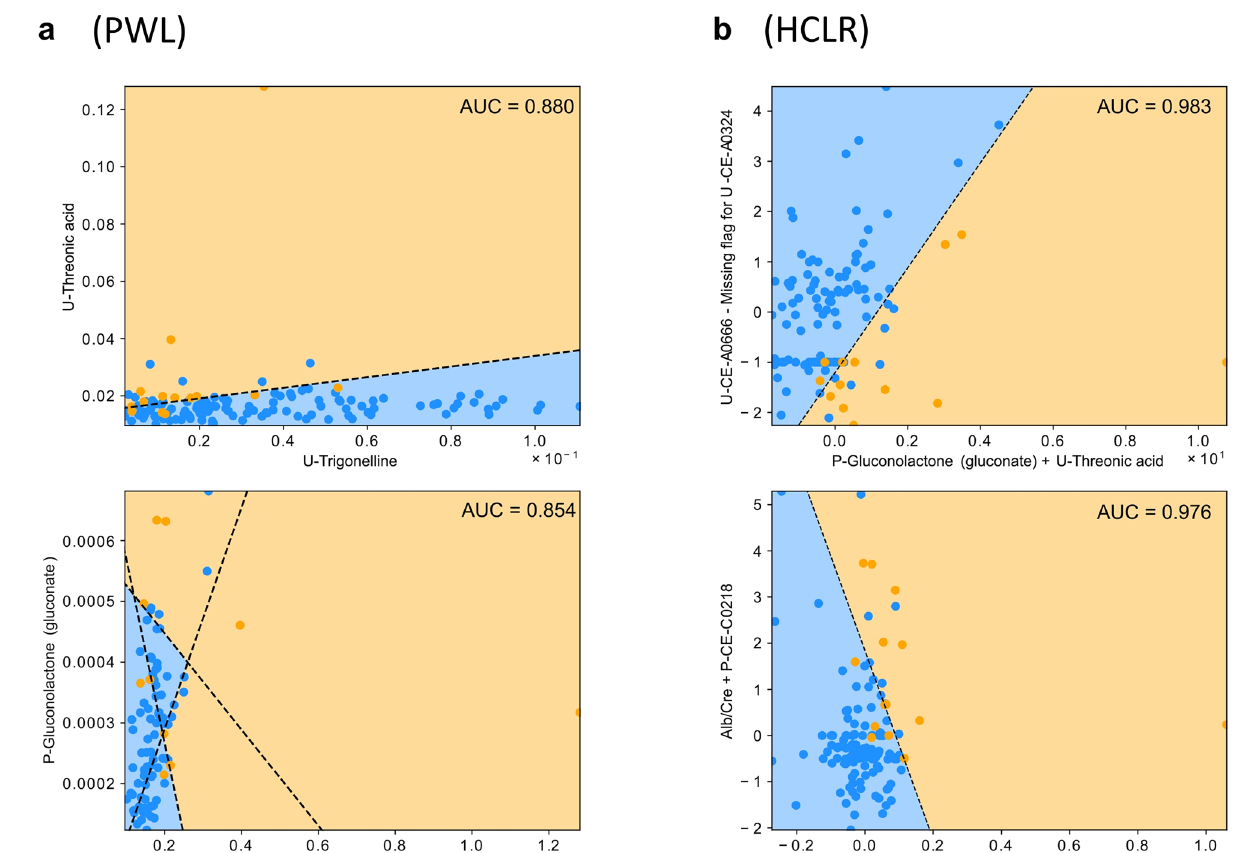
Figure 3. Representative plots of PWL model and HCLR model. Representative plots of ( a ) PWL and ( b ) HCLR models with high AUC values. The orange and blue areas show the regions classified as rapid decliners and others by each model, respectively. The orange and blue points correspond to the rapid decliners and others in the dataset, respectively. The dashed line represents the classification boundaries by setting the threshold level of the rapid decliner probability to the one with which the f1-measure was maximum. PWL piecewise linear, HCLR handcrafted linear